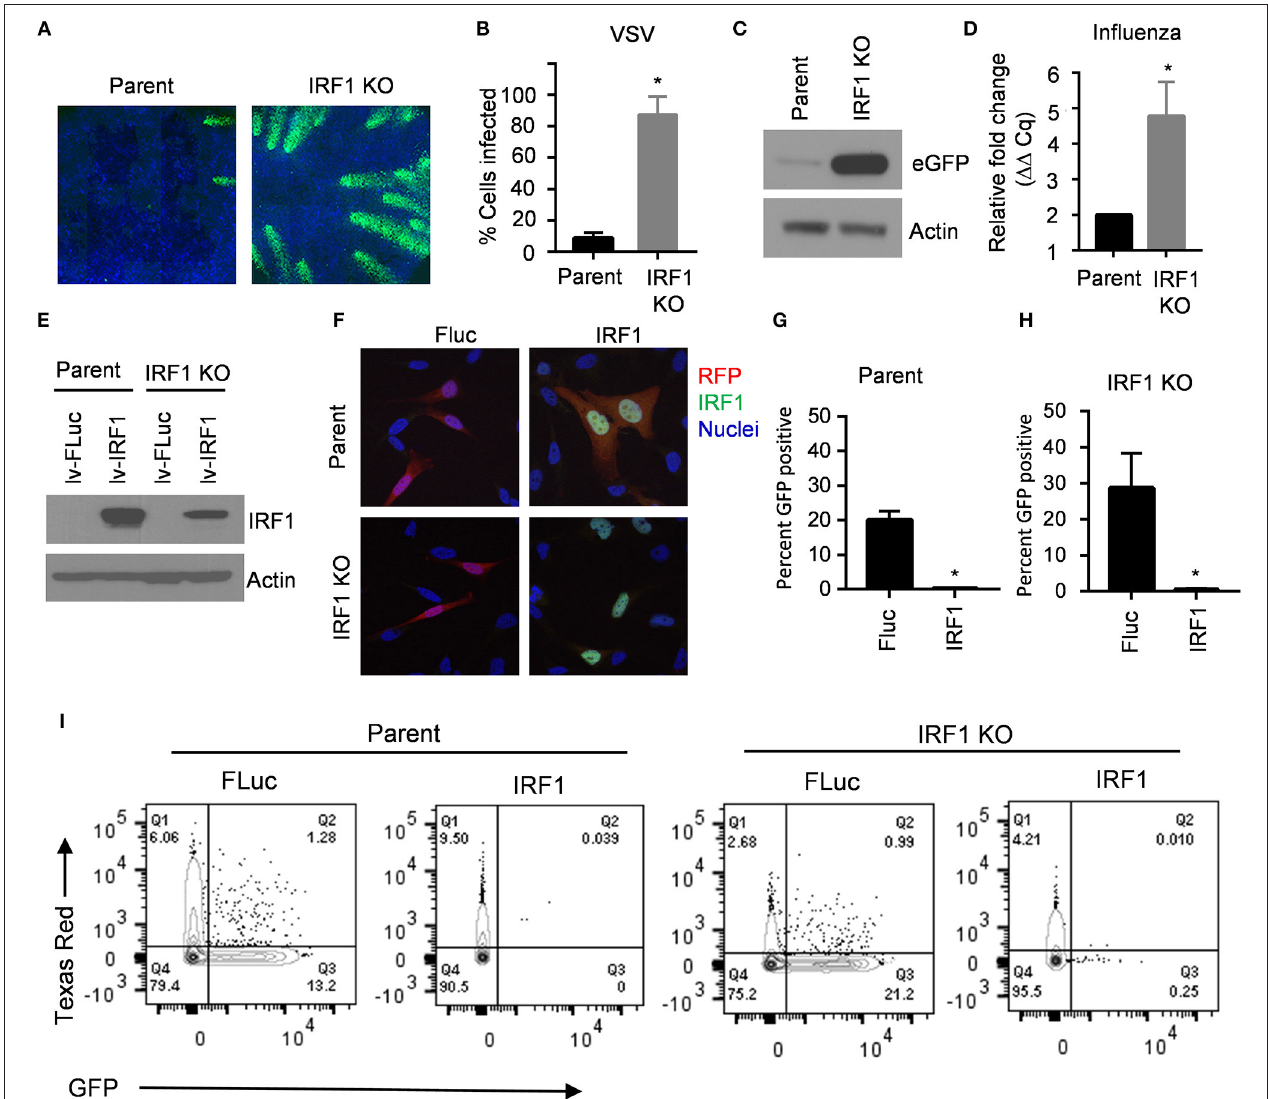
FIGURE 1 | IRF1 is necessary for restriction of VSV and influenza virus in BEAS-2B respiratory epithelial cells. (A–C) Parent and IRF1 KO BEAS-2B cells were infected with VSV at 0.01 MOI for 20h and VSV-encoded GFP expression was examined by imaging (A) , flow cytometry (B) , and immunoblotting (C) . The images shown in panel A are representative of three independent experiments. (B) Flow cytometry results of the percent cells infected (GFP + ) in three experiments is shown. Mean ± SD is plotted on the graph. (C) Immunoblotting for viral encoded GFP is shown. (D) Parent and IRF1 KO cells were infected with PR8 influenza virus and influenza matrix gene expression was examined by RT-qPCR. Relative fold change (2 − 11 Cq ) is shown. Data represent mean ± SD from three independent experiments. (E) Parent or IRF1 KO BEAS-2B cells were transduced with bicistronic lentiviruses encoded for tagRFP and either firefly luciferase (FLuc) or IRF1, and cell lysates were immunoblotted to confirm IRF1 expression. (F) Parent and IRF1 KO cells were transduced with the lentiviruses expressing tagRFP and Fluc or IRF1, and IRF1 localization was examined by immunofluorescence microscopy. Representative images are shown. (G–I) Parent and IRF1 KO BEAS-2B cells were transduced with lentiviruses, infected with VSV at 0.01 MOI for 20h, and harvested for flow cytometry. Data shown in (G) and (H) are mean ± SD from three independent experiments. Representative plots are shown in (I) . *Statistically